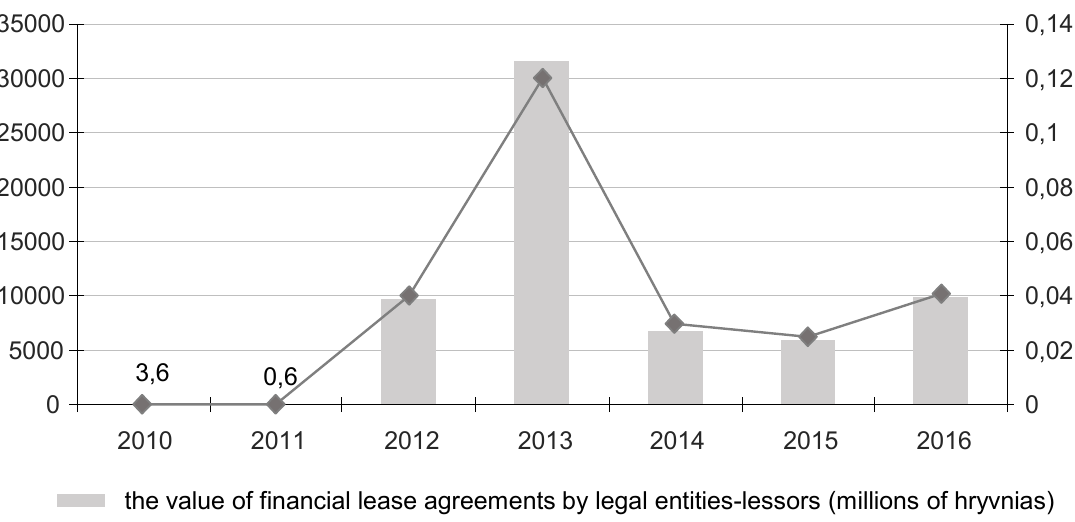
Source: statistical data from the State Commission for Regulation of Financial Services Markets of Ukraine (key performance indicators of financial companies and